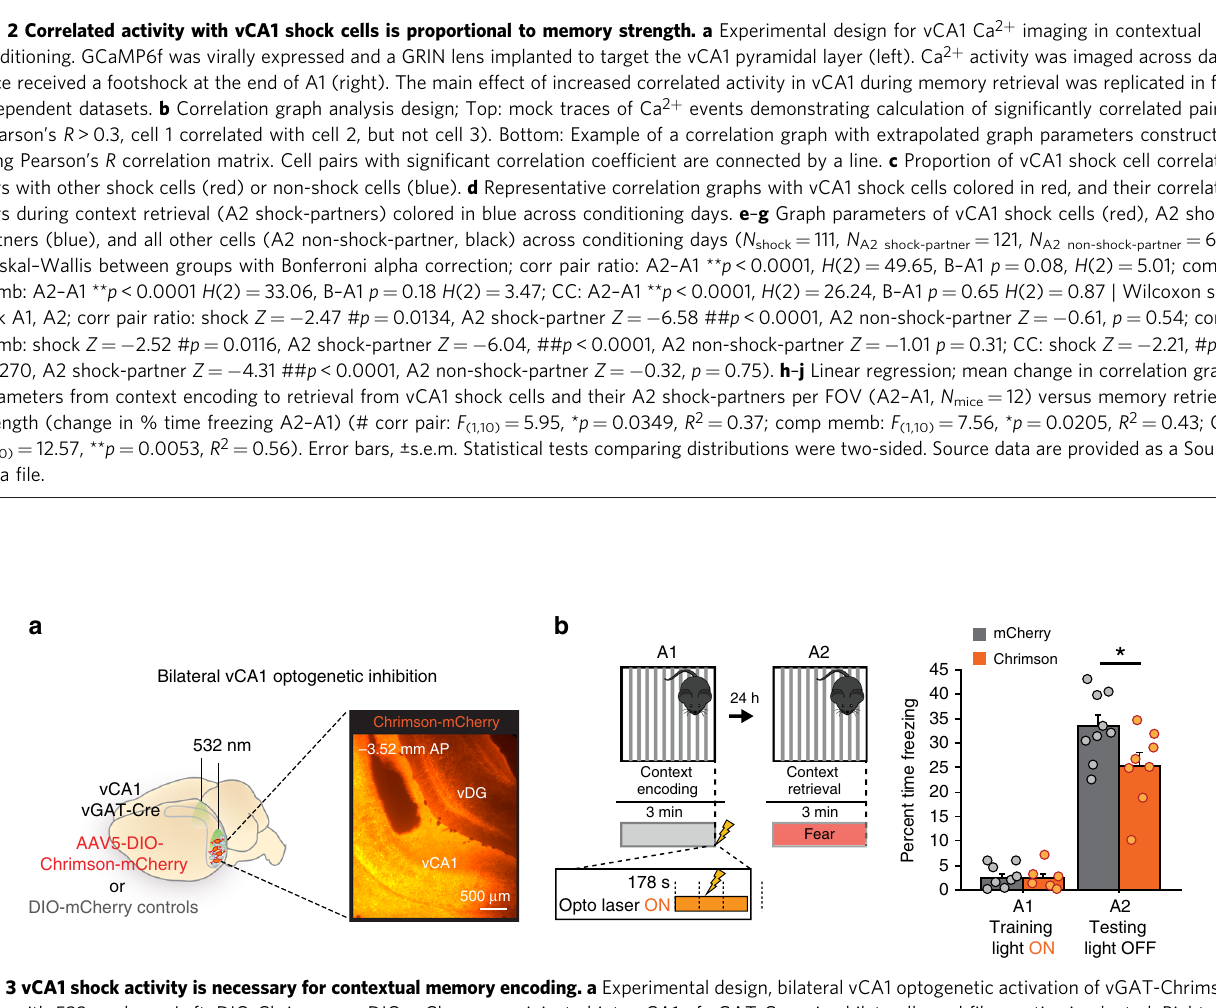
Fig. 3 vCA1 shock activity is necessary for contextual memory encoding. a Experimental design, bilateral vCA1 optogenetic activation of vGAT-Chrimson cells with 532 nm laser. Left: DIO-Chrimson or DIO-mCherry was injected into vCA1 of vGAT-Cre mice bilaterally and fi ber optics implanted. Right: Example image of vCA1 with expression of Chrimson, and fi ber optic targeting. The main effect of this experiment was replicated in an independent dataset within the lab. b Left: Experimental design, laser stimulation was delivered for 6 s during the footshock in A1 context encoding (ON 178 – 184 s). Right: Bilateral vCA1 shock silencing with vGAT-Chrimson stimulation during context encoding signi fi cantly reduced % time freezing during context retrieval relative to vGAT-mCherry control mice (repeated-measures ANOVA; % time freezing*genotype interaction F (1,15) = 6.26, * p = 0.0244, Chrimson N = 8, mCherry N = 9). Error bars, ±s.e.m. Statistical tests comparing distributions were two-sided. Source data are provided as a Source Data fi